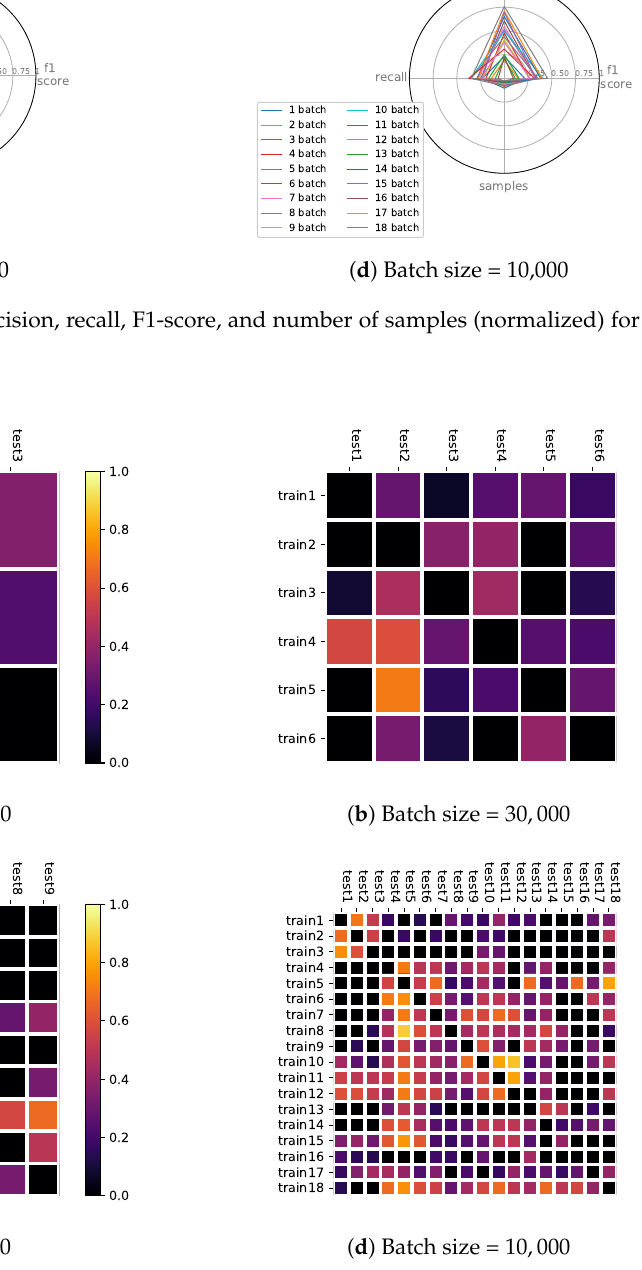
Figure 8. Mining Pool F1-score of each test in the four presented